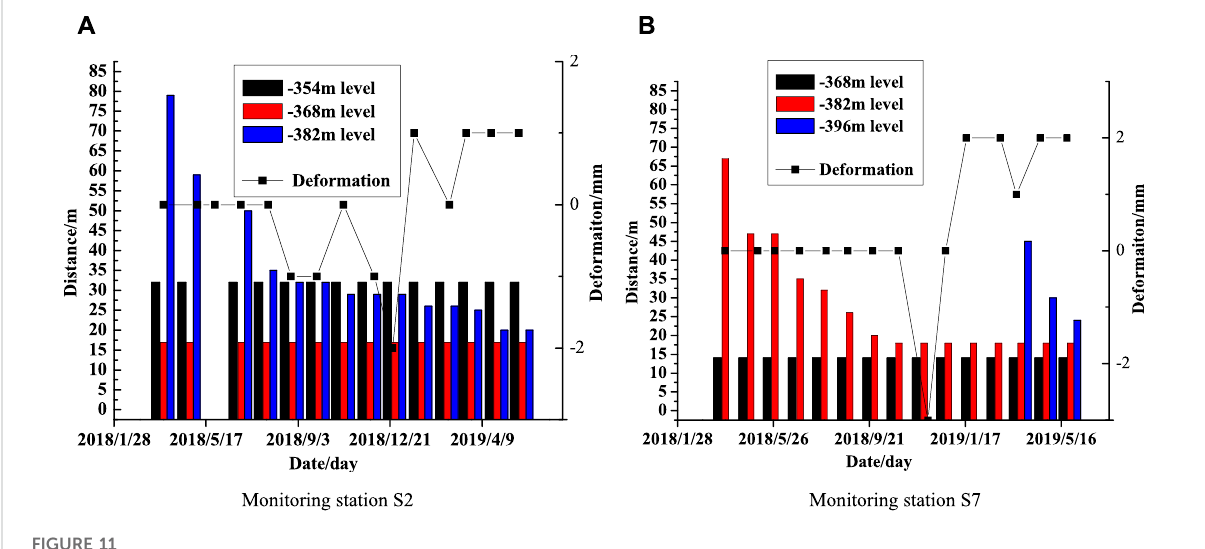
S2. (B) Monitoring station S7.